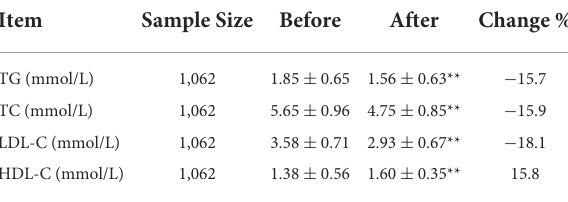
TABLE 2 Effect of daily NK consumption (10,800 FU daily) for 12 months on the lipid